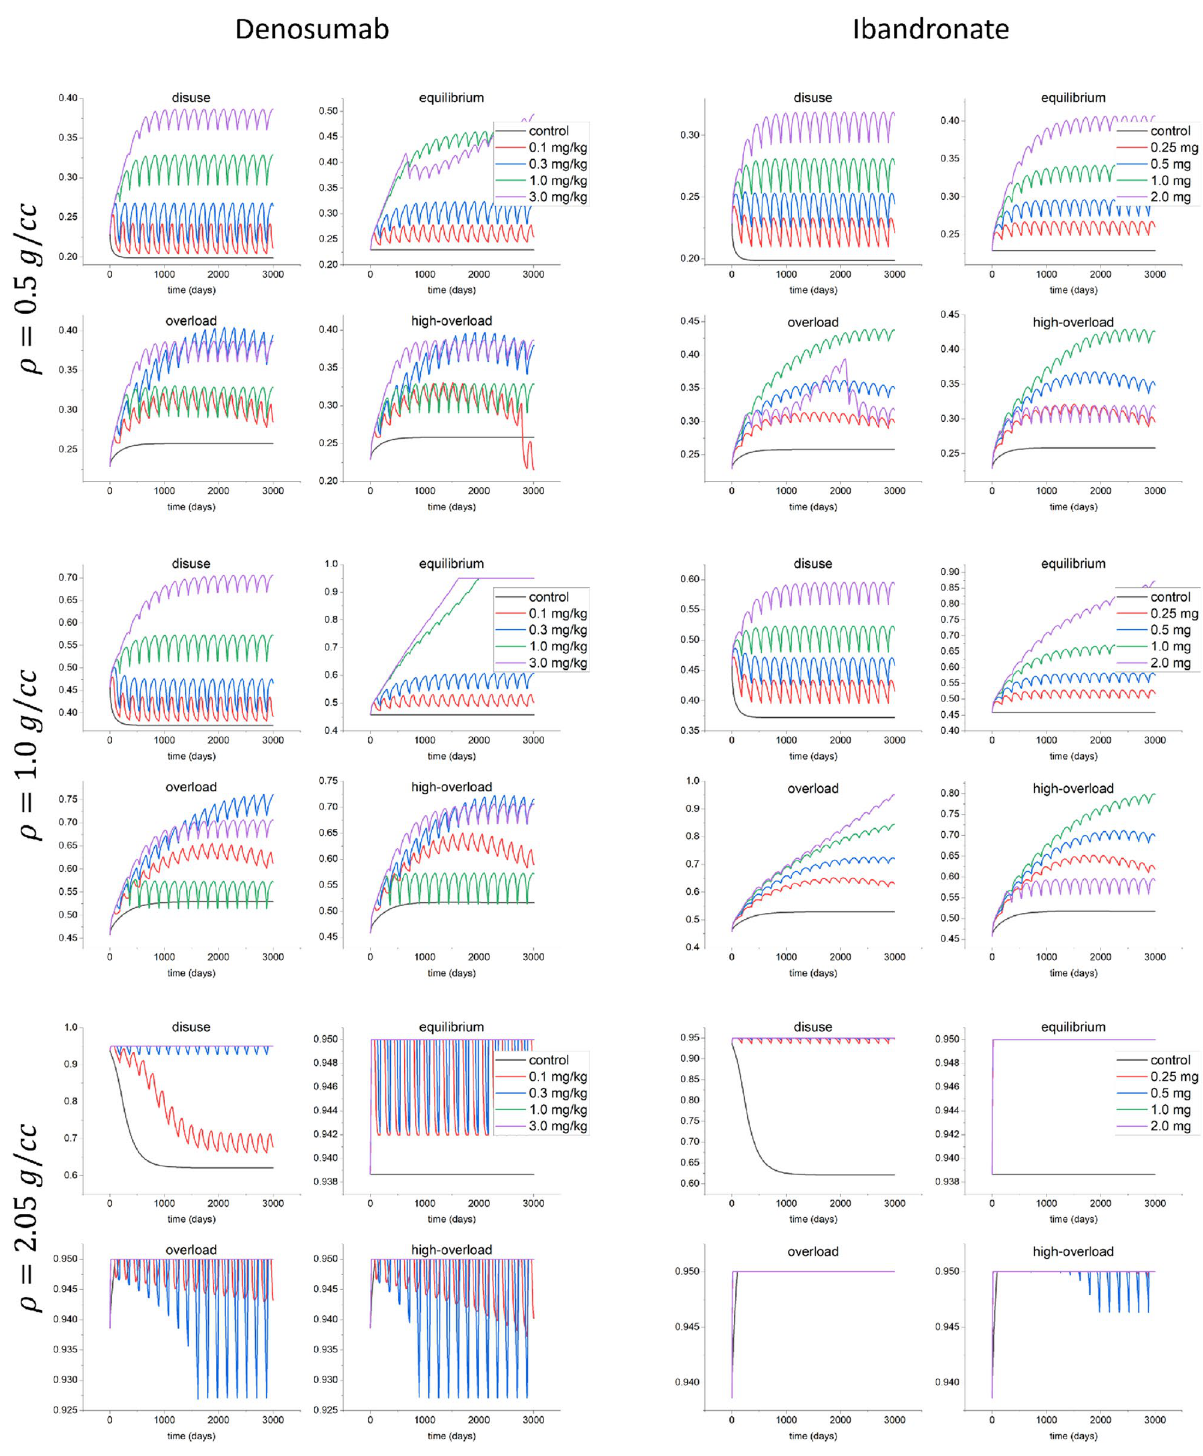
Figure 2. Evolution of the bone volume fraction (Eq. (2)) for the control case without drugs and for different doses of denosumab (0.1, 0.3, 1.0 and 3.0 mg/kg) and Ibandronate (0.25, 0.5, 1.0 and 2.0 mg) when applying ξ ∗ ), overload ( ξ 0 ), equilibrium ( ξ 5 ξ ∗ ) and high-overload ( ξ different stimuli of disuse ( ξ = = = 0.5, 1.0 and 2.05g / cm 3 different bone types ( ρ =